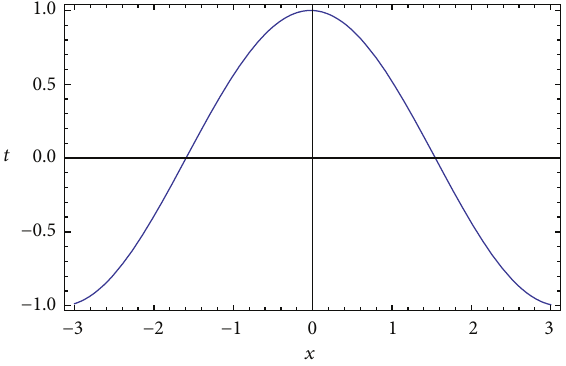
Figure 8: 3D, residual of 𝜂(𝑥, 𝑡) at 𝑡 = 0.1 .